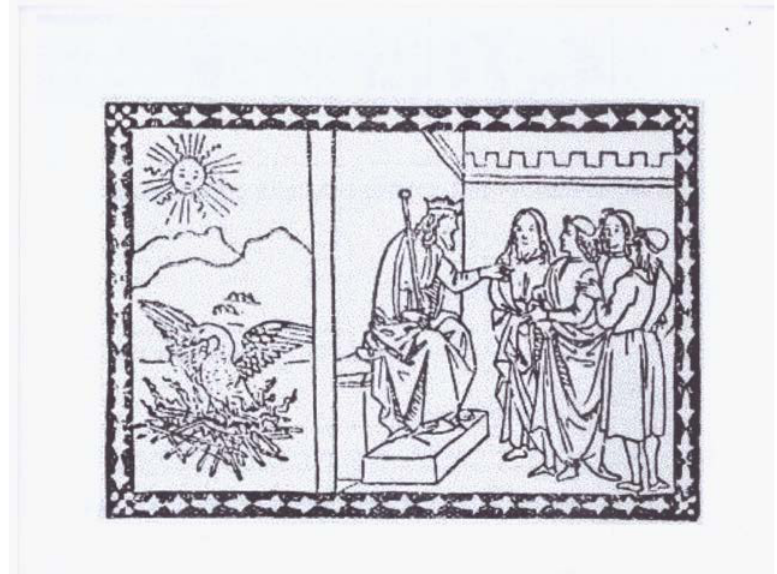
Figure 18 – Bernardo Pulci, La Rapresentatione divota di Barlaam et Iosafat , s.n.t. [but Firenze, Miscomini, around 1495], f. a5r (BNCF, Banco Rari 189.e). By permission of Ministero per i beni e le attività culturali / Biblioteca Nazionale Centrale. Firenze